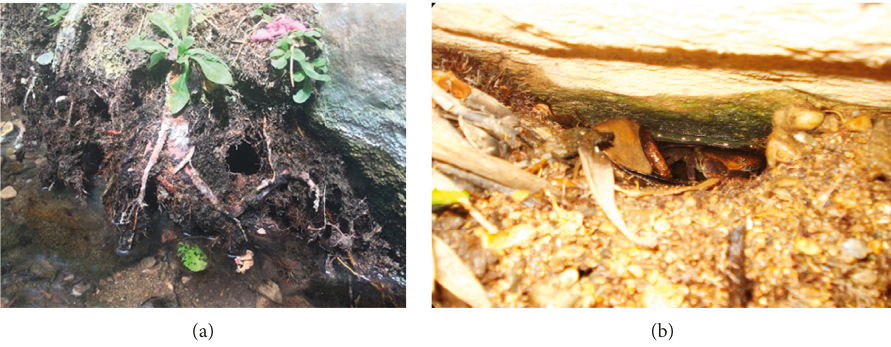
Figure 3: Habitat and burrows of the Potamon algeriense